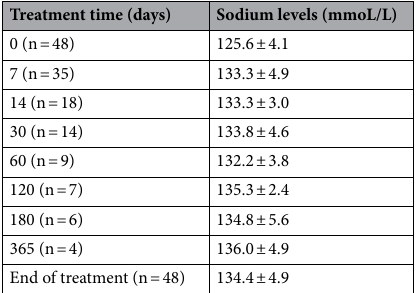
Table 3. Evolution of plasma sodium levels with urea treatment. Sodium levels are expressed as mean ± standard deviation.